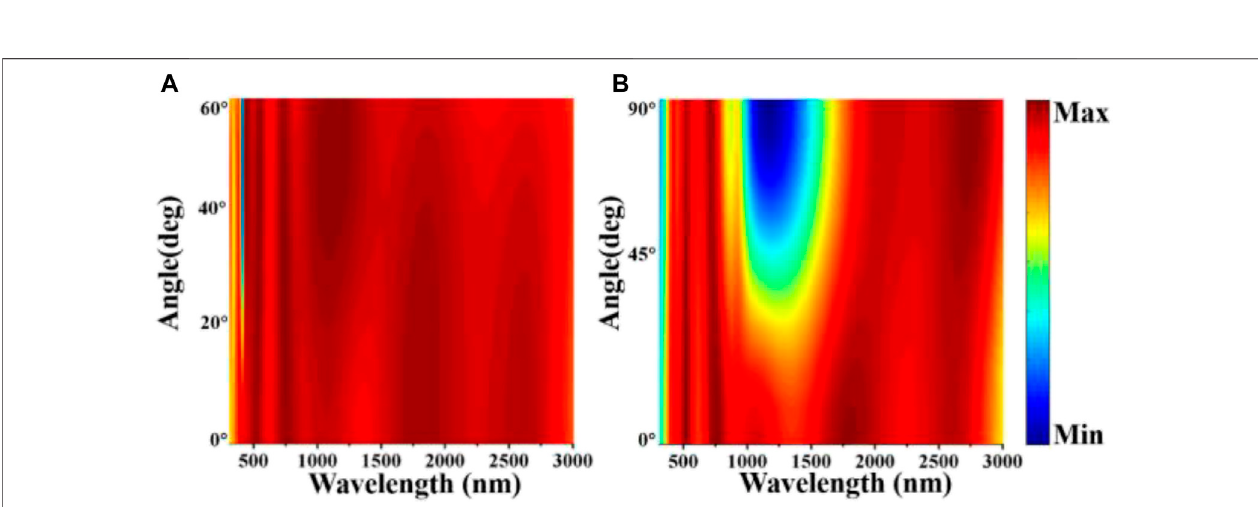
FIGURE 5 | (A) Absorption spectra at different oblique incidence angle. (B) Absorption spectra at different polarization angles.